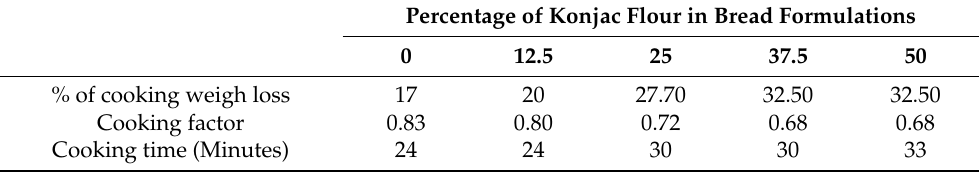
Table 1. Cooking characteristics of different formulations of gluten-free bread samples.